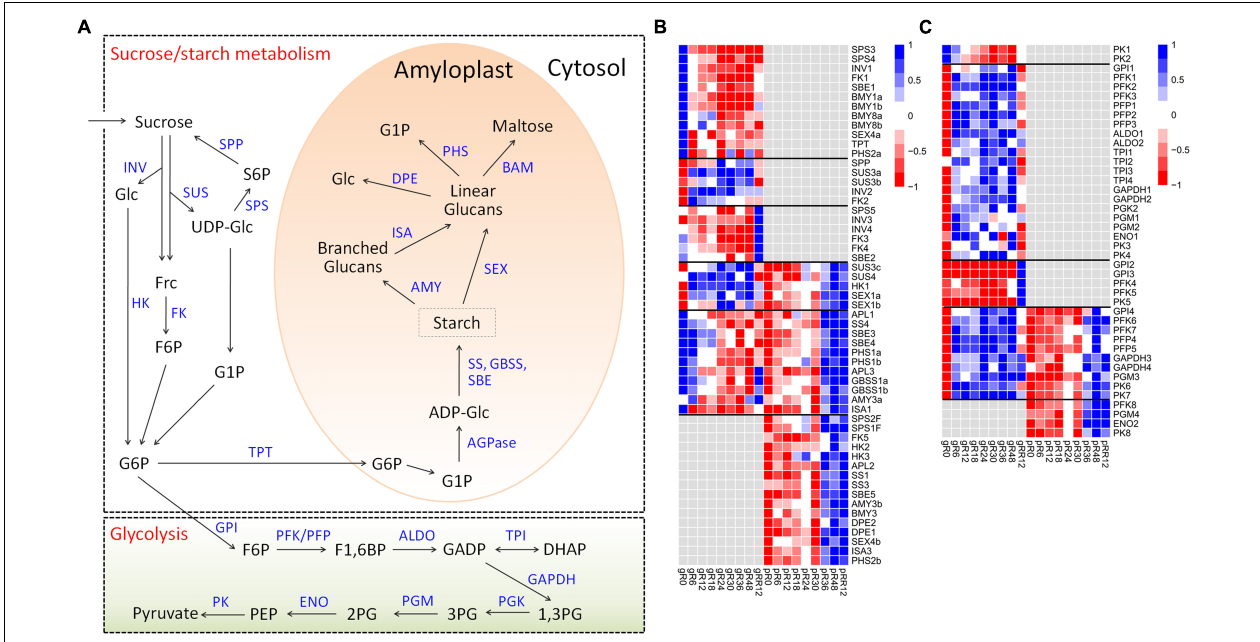
FIGURE 4 | Expression profiles of DEGs and DEPs related to sucrose-starch metabolism and glycolysis during flooding stress. (A) Summary of pathways of sucrose-starch metabolism and glycolysis. (B) Heatmap of DEGs and DEPs related to sucrose-starch metabolism. (C) Heatmap of DEGs and DEPs involved in glycolysis metabolism. The samples are prefixed as follows: g, transcriptomic level; p, proteomic